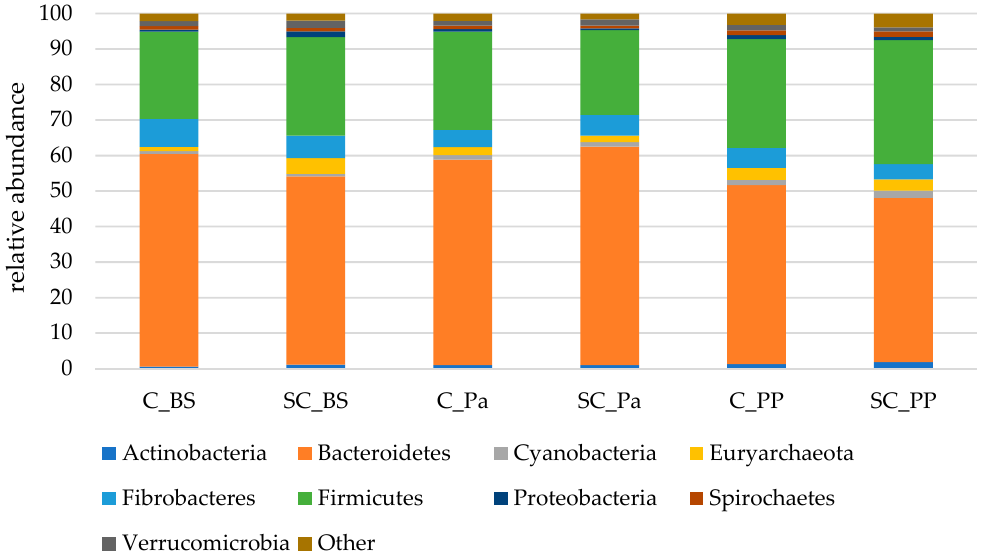
Figure 3. The relative abundances of the main bacterial and archaeal phyla in the rumen contents of both the experimental groups (Control C and Supplemented SC, n = 6 per group) BS (before supplementation), Pa (close to parturition) and PP (2 weeks postpartum).